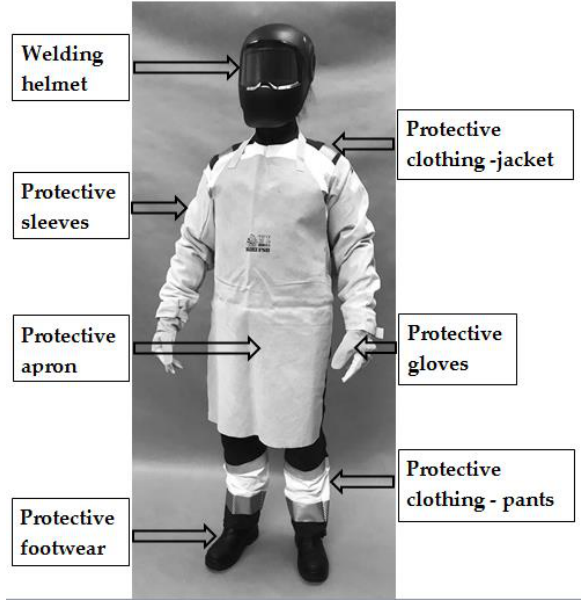
Figure 3. View of the subject wearing the welding PPE kit used in the study. Table 1. Characteristics of the personal protective equipment used for tests.